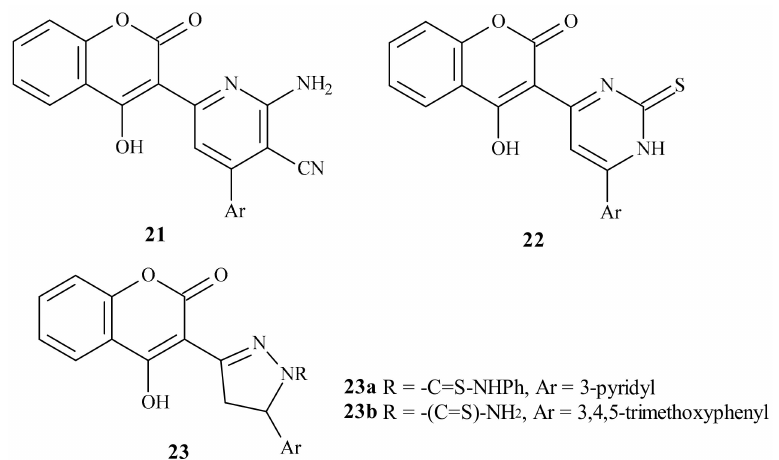
Figure 9. The examples of 4-hydroxycoumarin derivatives, which antagonize VKOR.